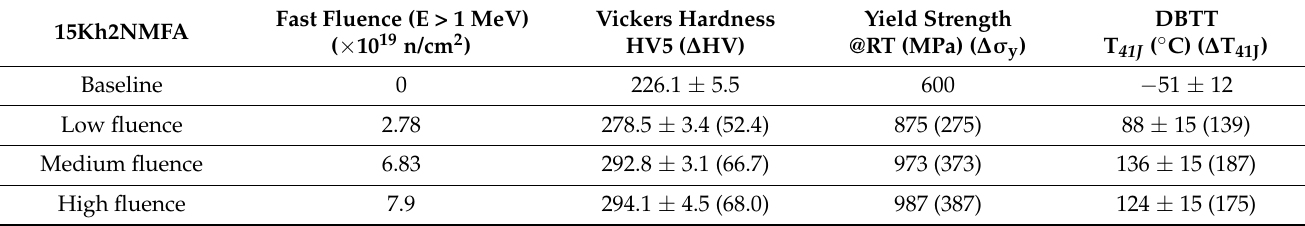
Table 4. Fast fluence (E > 1 MeV), Vickers hardness (HV5), yield strength (hardening ∆ σ y ), and DBTT (embrittlement ∆ T 41J ) for 15Kh2NMFA.